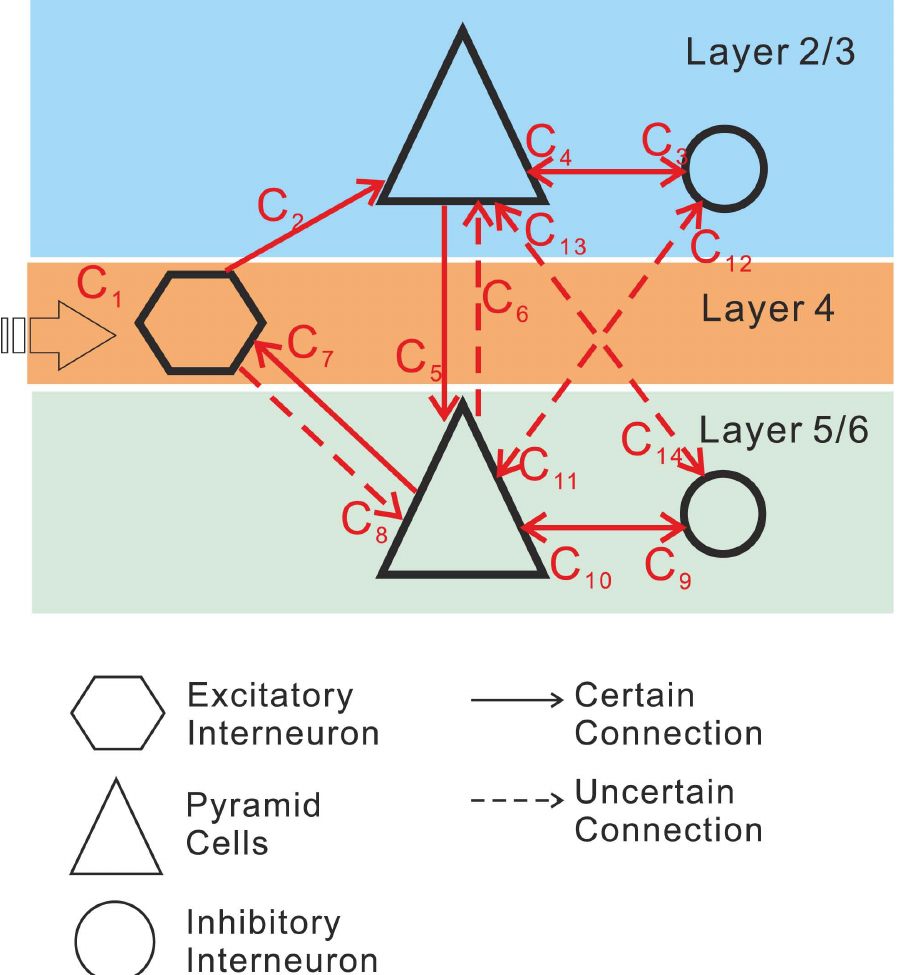
Figure 2. Neural mass model for a cortical source with excitatory interneurons (EIN) in layer 4, superficial pyramidal cells (sPC) in layers 2/3, deep pyramidal cells (dPC) in layers 5/6, as well as two inhibitory interneuron populations (sIIN, dIIN).